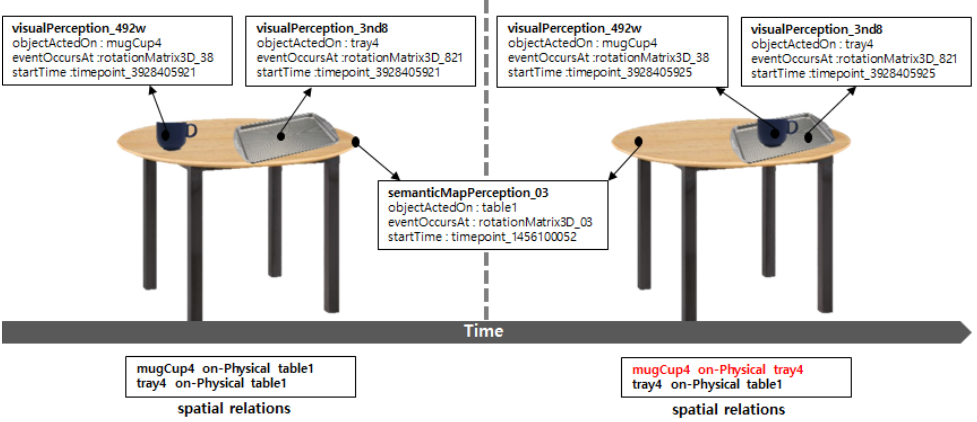
Figure 3. An example of 3D spatial relations between objects.